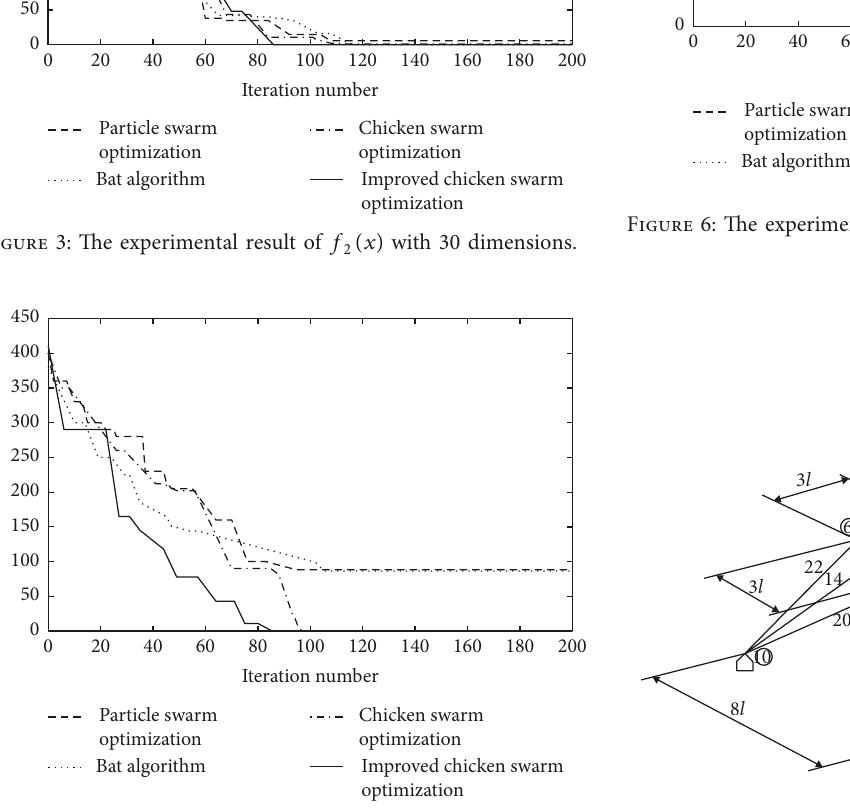
Figure 7: Schematic diagram of the 25bar space truss ( x ) with 30 dimensions. 3